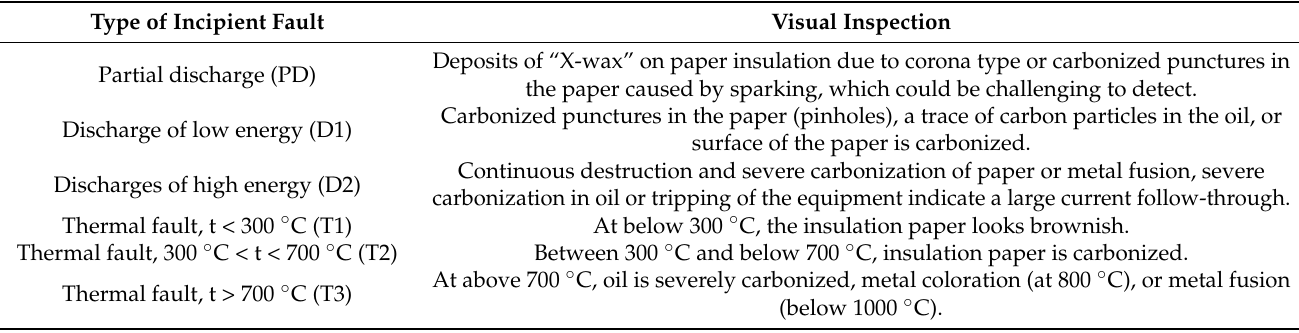
Table 1. Type of oil faults and visual inspections of them [8].